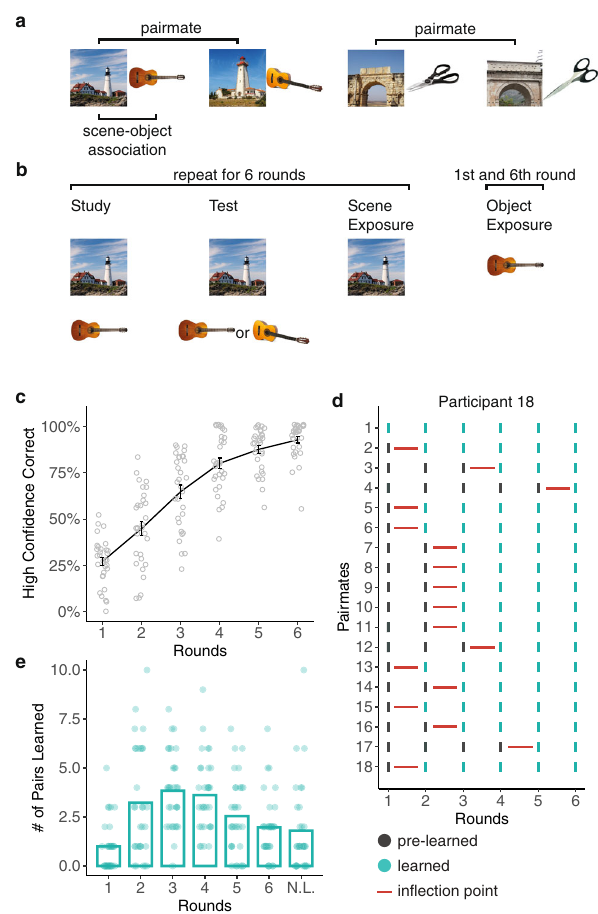
Fig. 1 Experimental design and behavior. a Participants learned 36 scene- object associations. The 36 scenes comprised 18 scene pairmates which consisted of highly similar image pairs (e.g., “ lighthouse 1 ” and “ lighthouse 2 ” ). Scene pairmates were also associated with similar objects (e.g., “ guitar 1 ” and “ guitar 2 ” ). b Participants completed six rounds of study, test, and exposure phases. During the study, participants viewed scenes and associated objects. During the test, participants were presented with scenes and had to select the associated object from a set of two choices, followed by a con fi dence rating (high or low con fi dence; not shown). During exposure, scenes (rounds 1 – 6) or objects (rounds 1 and 6) were presented and participants made an old/new judgment. fMRI data were only collected during the scene and object exposure phases. c Mean percentage of high con fi dence correct responses for each test round. d Data from a representative participant showing the “ in fl ection point ” in learning (red horizontal line), for each pairmate. The in fl ection point was de fi ned as the point at which participants transitioned to high con fi dence correct retrieval for both scenes within a pairmate — a transition from “ pre-learned ” (black) to “ learned ” (aqua). e Mean number of scene pairmates that transition to a learned state at each round. N.L. indicates pairmates that were never learned. Notes: Data were presented as mean values± SEM, n = 31 independent participants. Source data are provided as a Source Data fi